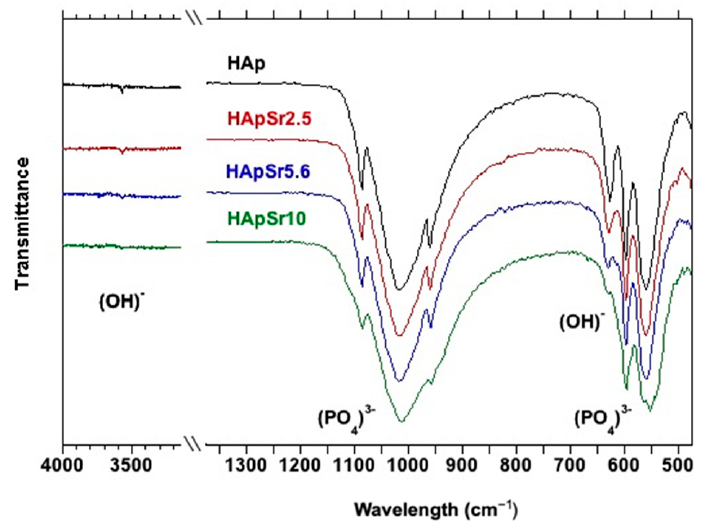
Figure 9. FTIR spectra of Sr-doped HAp samples together with undoped HAp.